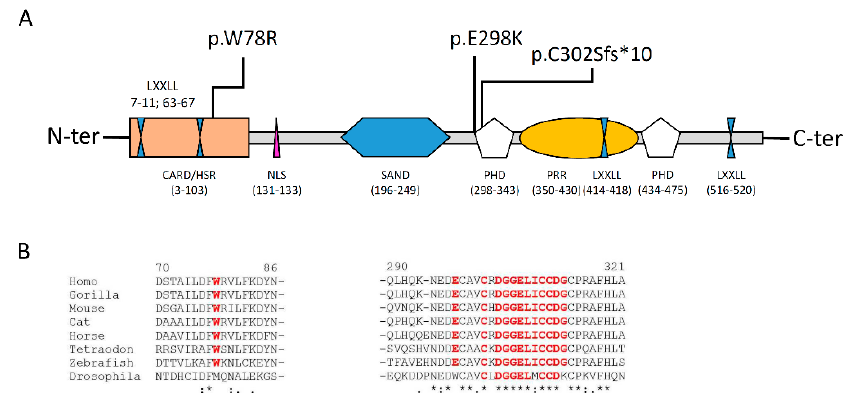
Figure 3. ( A ): Structure of the AIRE protein and description of the di ff erent domains (please see to text for details); ( B ): Homolog sequence multialignment showing the level of conservation of the aminoadic sequence in di ff erent orthologues. In red the residues resulted in mutation or the sequence following the frameshift deletion.